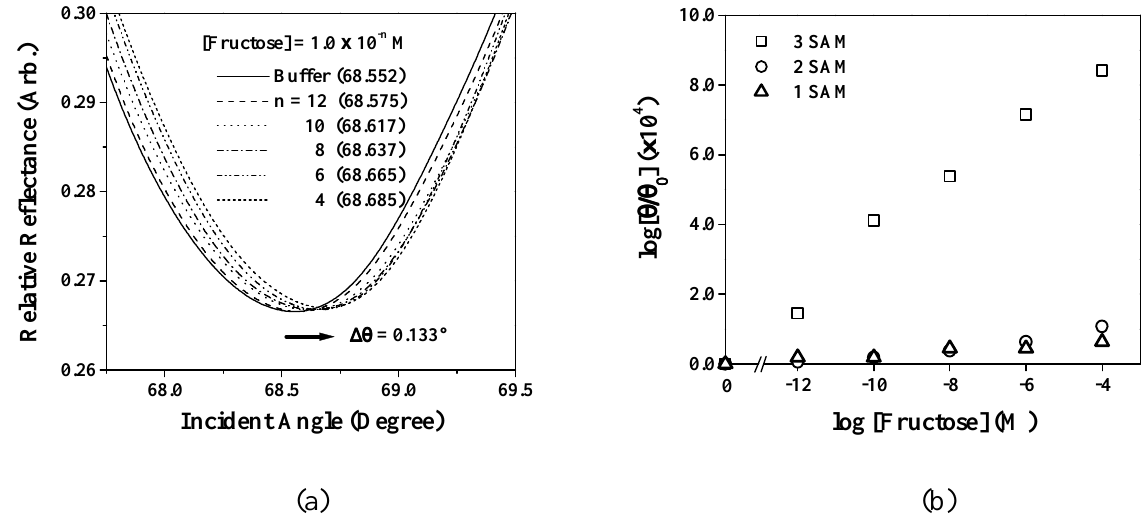
Figure 6 . (a) SPR angle shifts of 3 monolayer (n = 3) according to various concentrations of fructose. The arrow indicates the direction of SPR angle shifts. The values in parenthesis mean SPR angle at each concentration of fructose. (b) Relative SPR angle shifts of phenylboronic acid monolayers with different alkyl spacer length (n =1, 2, 3) according to various concentration of